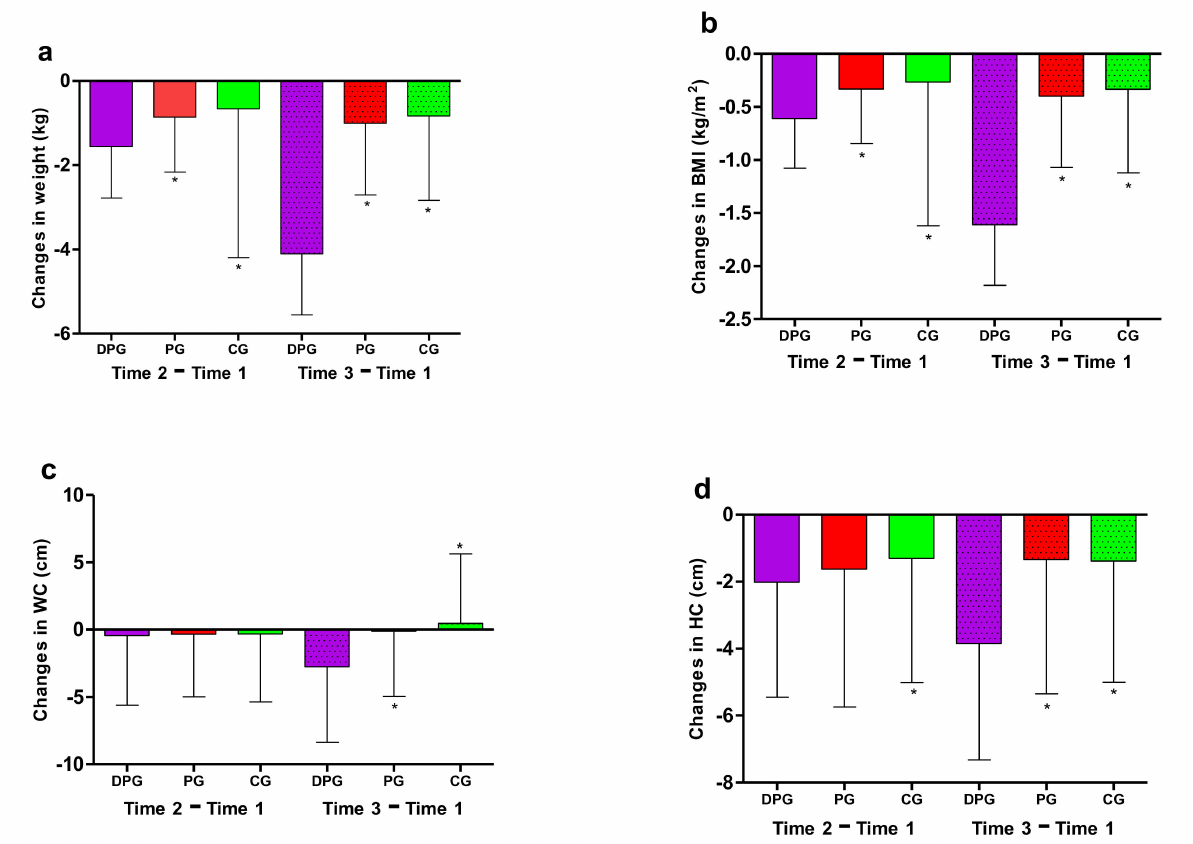
Figure 5. Changes in weight outcomes at Time 1 and Time 2 compared to baseline. Changes in weight outcomes included ( a ) changes in weight, ( b ) changes in body mass index (BMI), ( c ) changes in waist circumference (WC) and ( d ) changes in hip circumference (HC). DPG: dietary and physical activity interventions group; PG: physical activity interventions group; CG: control group; * p < 0.05 for the comparison of changes with